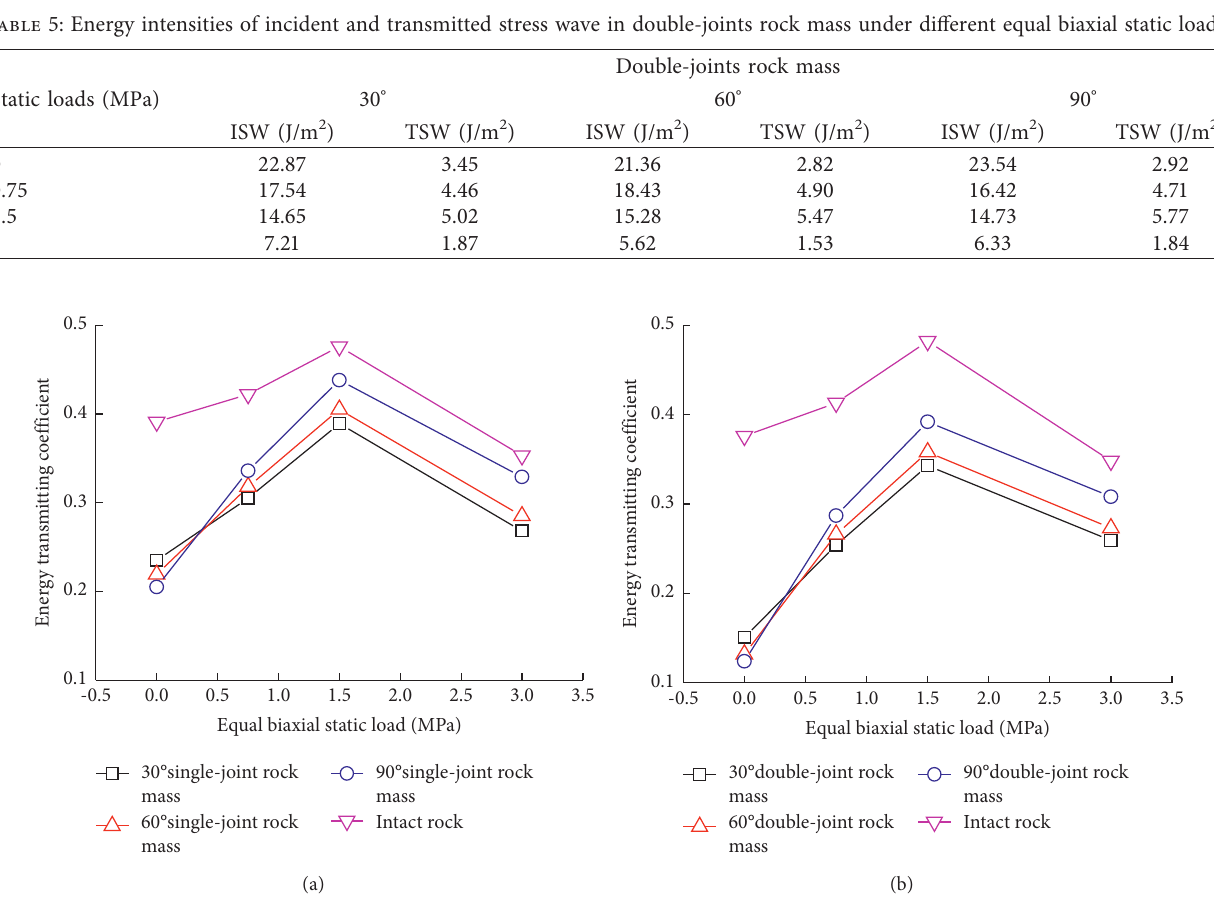
Figure 16: Energy transmitting coefficients of stress wave in jointed rock masses with different angles and numbers under equal biaxial static loads. (a) Single-joint rock mass. (b) Double-joints rock